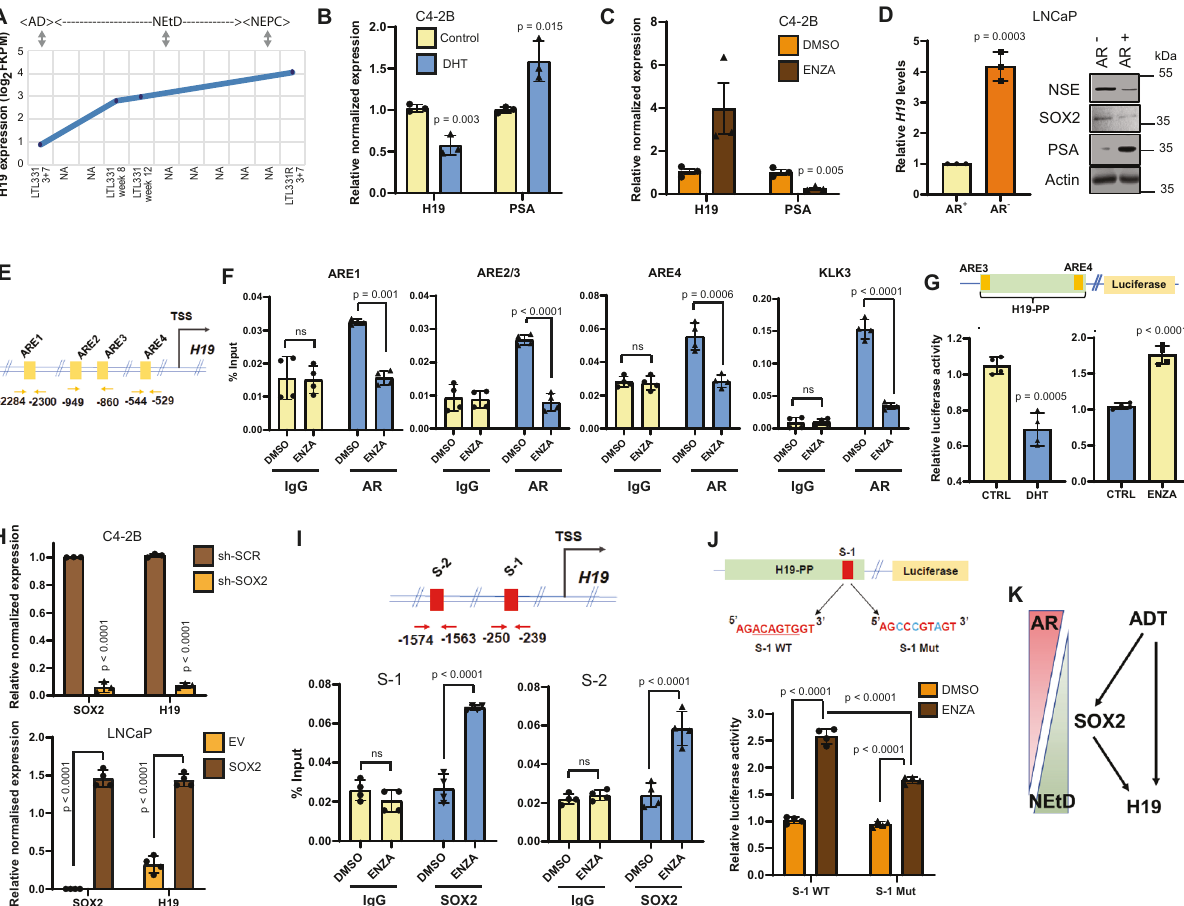
Fig. 5 Androgen deprivation causes direct binding of SOX2 on the H19 promoter upregulating its transcription during NEtD. A H19 RNA expression during different phases of NEtD in the LTL331 system ( n = 1). B Relative RNA expression of H19 and PSA in C4-2B cells after DHT (10 ng, 48 h) treatment vs. control (EtOH). C Same as B after ENZA (10 µ M, 5 days) treatment vs. DMSO. D Relative RNA expression of H19 in androgen starved (AR − ) LNCaP cells placed in phenol-free media with 10% CSS for 40 days. LNCaP cells grown in regular media (AR + ) are controls. The right panel demonstrates WB assay for indicated proteins and Actin (control) using cells in the left. E Genomic location of AR binding motifs (ARE) on H19 promoter. F In C4-2B cells vs. control (DMSO) cells, ChIP-qPCR showed AR binding on H19 promoter and a decrease with ENZA (10 µ M) treatment. The KLK3 promoter served as a positive control. G Schematic showing luciferase reporter construct with the proximal promoter of H19 (H19-PP) harboring ARE sites (ARE 3 – 4) (top). Luciferase reporter activity of the H19-PP in DHT (10 nM) stimulated cells vs. ethanol (control) treatment. The right panel is the same, except for ENZA (10 µ M) treatment of C4-2B cells. H Relative RNA expression of SOX2 and H19 in C4-2B cells stably expressing sh-SOX2 vs. sh-SCR control (top); and stably expressing SOX2 vs. empty vector control transduced cells (bottom). I Genomic location of SOX2 binding motifs (S-1, S-2) on the H19 promoter. Bar plots demonstrating ChIP-qPCR are showing enrichment of SOX2 on the H19 promoter upon ENZA (10 µ M) and DMSO (control) treatment in C4-2B cells (bottom). J Schematic showing luciferase reporter constructs with H19-PP wild-type (S-1 WT) or mutated (S-1 Mut) SOX2 binding site (mutation in blue) (top). Bar plots showing luciferase reporter activity of H19-PP WT-S1 or Mut-S1 in ENZA (10 µ M) treated 42D ENZR cells (bottom). K Diagram depicting the regulation of H19 during NEtD mediated by androgen deprivation (ADT) and consequently via SOX2. Data are mean ± SD ( B , D , F – J ), or mean ± SEM ( C ); n = 3 ( B , C , D , H ) or n = 4 ( F , I , J ) biological replicates. p Values were calculated by unpaired two-tailed Student ’ s t test ( B – D , G – I) or two-way ANOVA multiple comparisons test ( F , J ). activity 44 . To test whether this interaction is essential for NEtD, H3K27me3 while only slightly reducing EZH2 expression (Fig. 6D). Together these data indicate that H19 plays a role in the we created an EZH2 binding site deletion fragment (H19 DEL , Supplementary Fig. 13B), with a 5 ′ deletion, and cloned it into a epigenetic changes induced during NEtD. H19 overexpression in DOX inducible Tripz vector. The addition of DOX to these cells LNCaP was shown not to alter the expression levels of PRC2 induced NE marker expression in H19 FL but not in the H19 DEL complex proteins, EZH2, SUZ12, and AEBP5 (data not shown), transfected LNCaP cells (Fig. 6F, Supplementary Fig. 13C, D). whereas RNA immunoprecipitation (RIP) in LASCPC-01 These results establish the functional importance of H19/EZH2 (Fig. 6E) and NCI-H660 (Supplementary Fig. 13A) demon- binding in mediating NEtD. strated the binding of EZH2 to H19 . RIP analysis of LNCaP and To determine the functional epigenetic landscape of changes V16D CRPC cells overexpressing H19 con fi rmed that the H19 transcript was enriched in the immunoprecipitation of endo- induced by H19 , ChIP-sequencing was performed on H3K27me3 genous EZH2 (middle) and SUZ12 (right) (Fig. 6E). It has been and H3K4me3 in V16D CRPC transduced with H19 (to induce reported that the association of H19 with EZH2 at a speci fi c NEtD) versus V16D CRPC control cells. We observed signi fi cant differential binding of H3K27me3 and H3K4me3 in V16D/H19 region in the 5 ′ end of the lncRNA is responsible for PRC2 NATURE COMMUNICATIONS| (2021) 12:7349